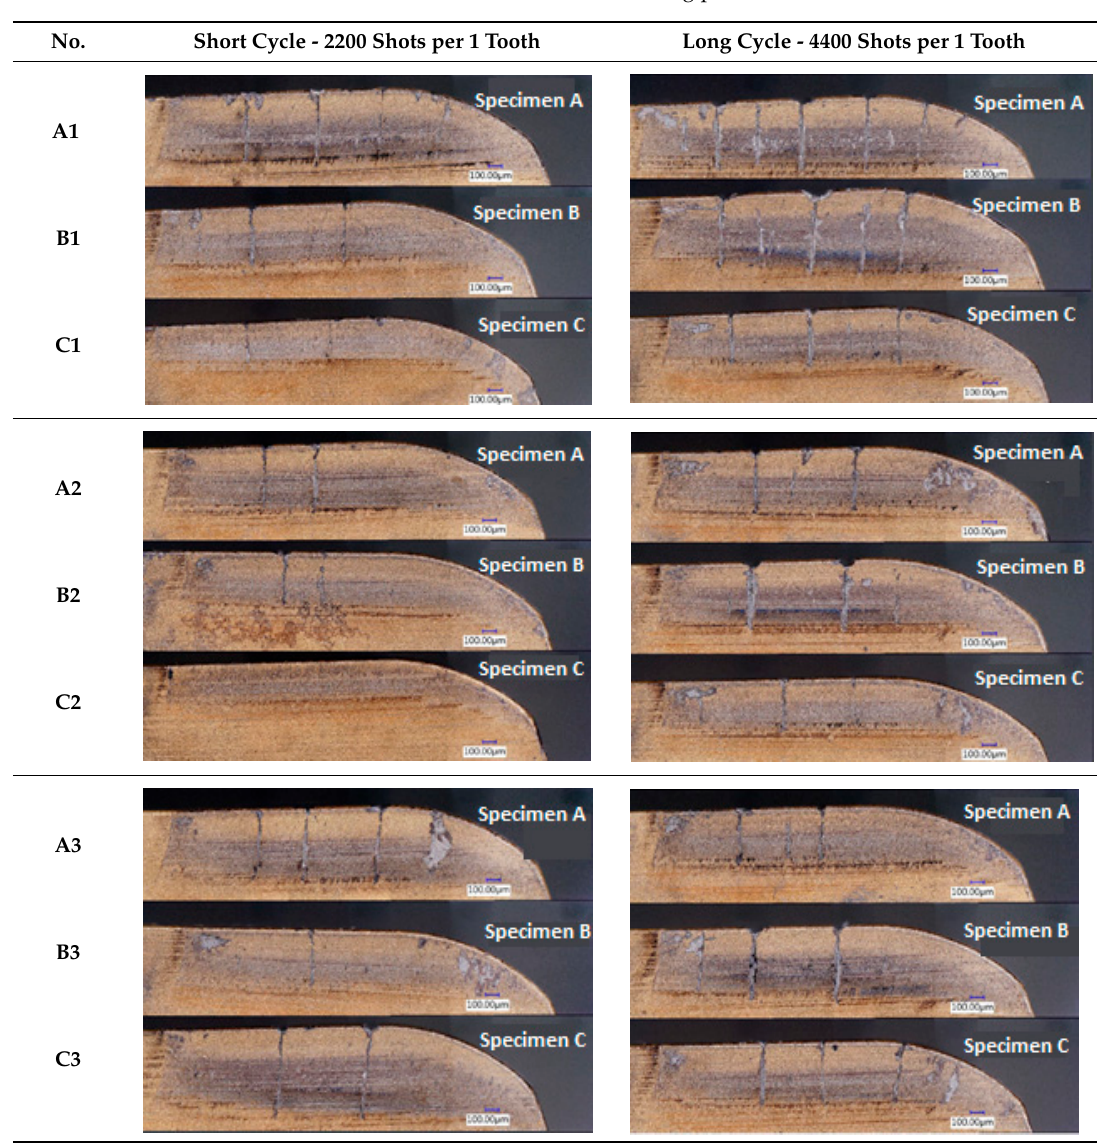
Table 7. Thermal cracks after milling process.